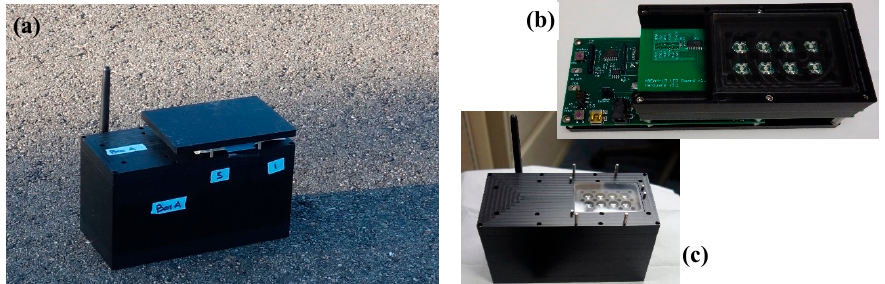
Figure 2. Images of the ABEAM-15 prototype sensor. The device includes fifteen surface-mounted RGB sensors, eight cool white LEDs, and three printed circuit boards. This device can be utilized autonomously or with a wireless tether to a laptop for real time detection. ( a ) The ABEAM-15 in an outdoor environment. ( b ) The ABEAM-15 board stack with indicator support. ( c ) The ABEAM-15 with sun cover removed. Additional detail provided in the Supplementary Information, Figures S3 and S4.